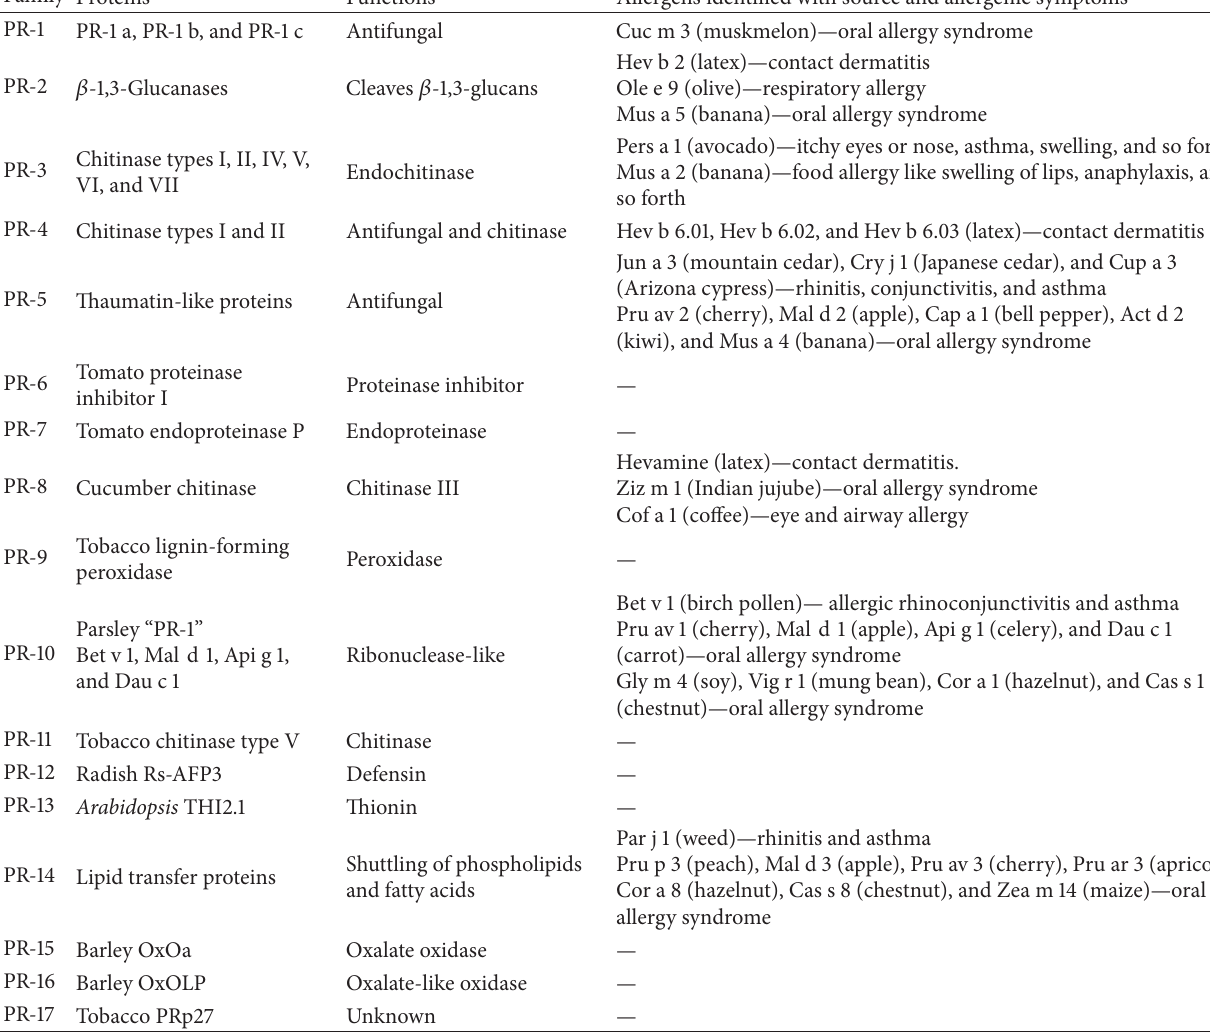
Table 1: Different PR-protein families and allergens